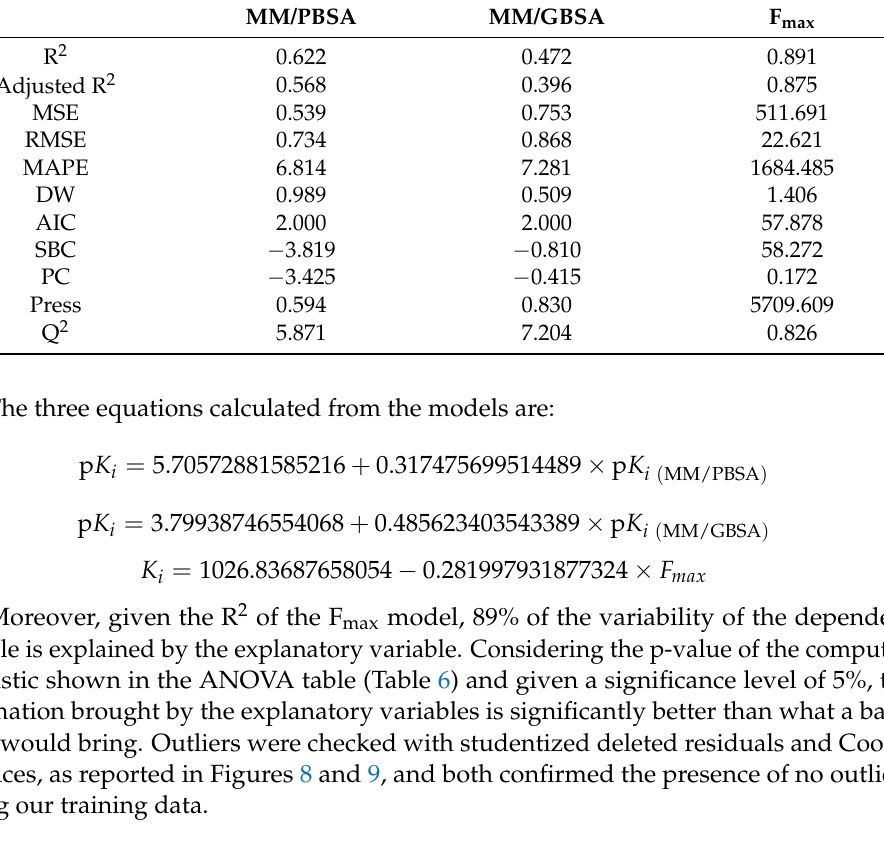
Table 5. Goodness of fit statistic for MM/PBSA, MM/GBSA, and F max models.